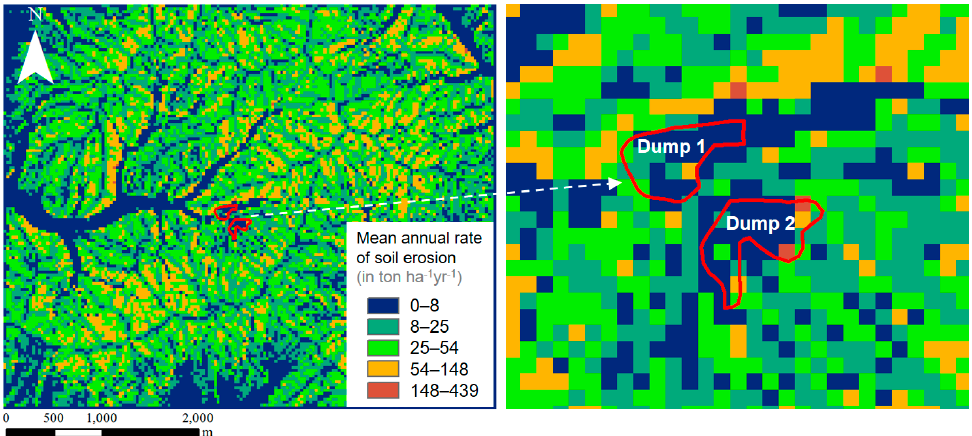
Figure 4. Mean annual rate of sediment yield (in ton ha − 1 year − 1 ) from each mine tailing dump using GIS ‐ based spatial analysis and the USLE model [23].